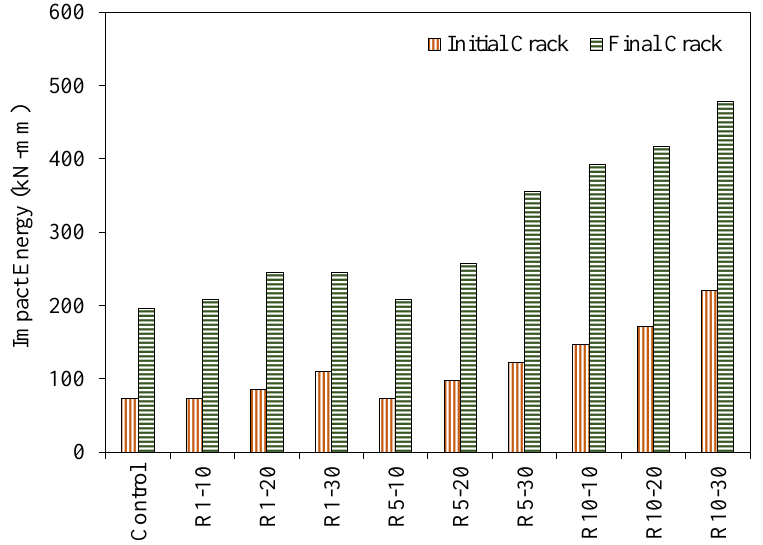
Figure 15. Impact energy for the mixture incorporating various rubber sizes and dosages.